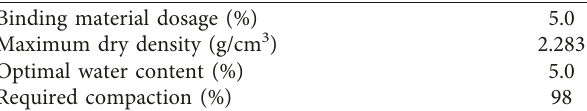
Table 2: Table of physical parameters of semirigid